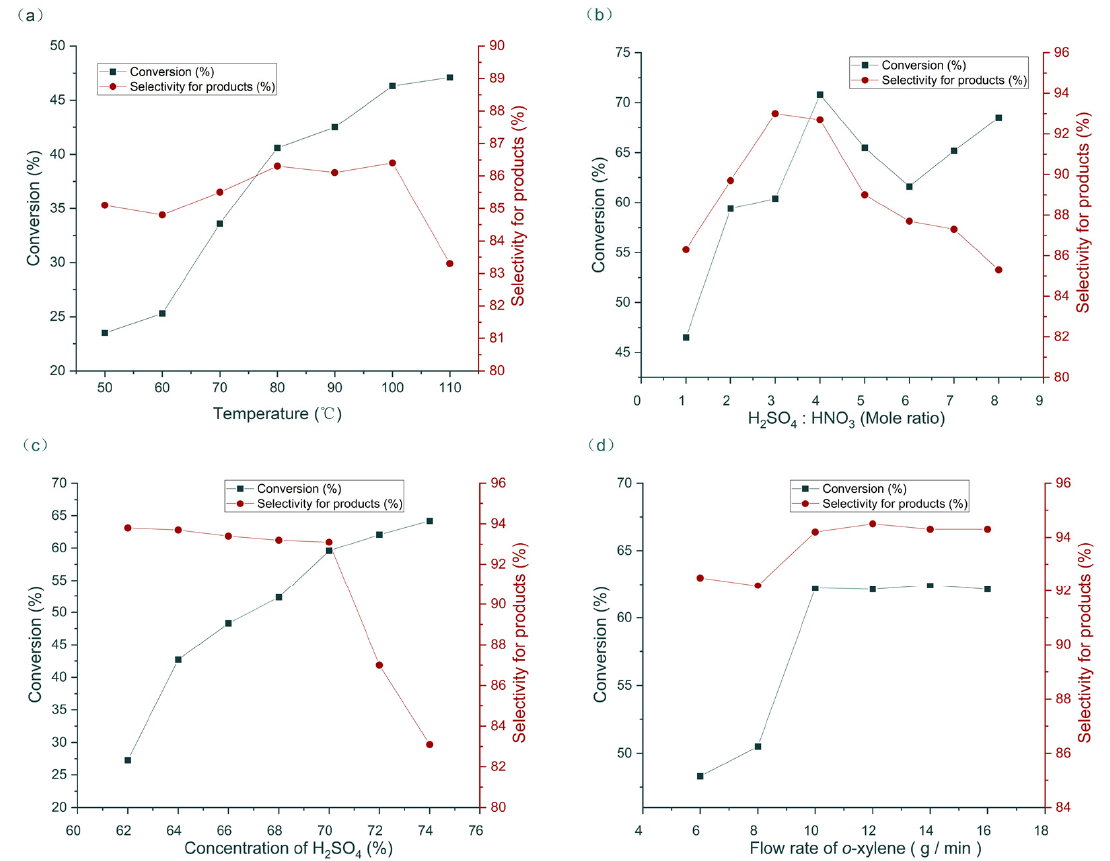
Figure 3. Optimization of nitration in continuous flow. ( a ) The influence of temperature; ( b ) the influence of mole ratio of H 2 SO 4 and HNO 3 ; ( c ) the influence of H 2 SO 4 concentration; ( d ) the influence of flow rate.